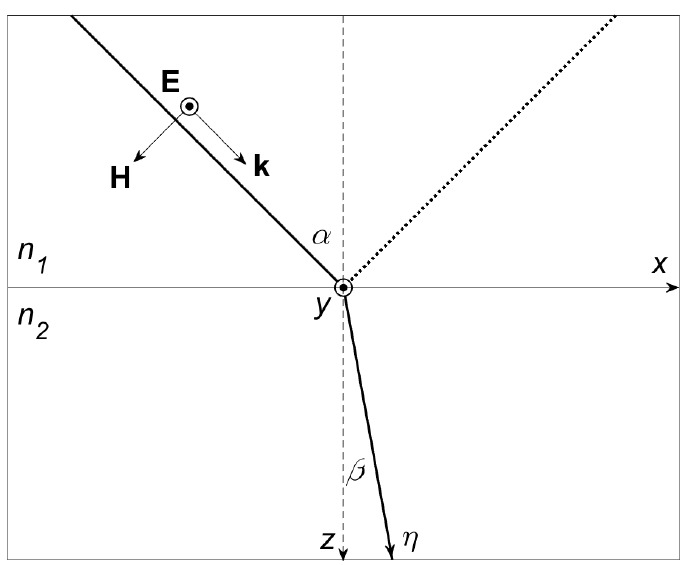
Figure 1. S -polarized wave. Bold line is the direction of propagation of a direct wave (ray trajectory). Dotted line is the direction of propagation of the reflected wave. A thin line is the interface between the media. The dashed line is normal to the interface.